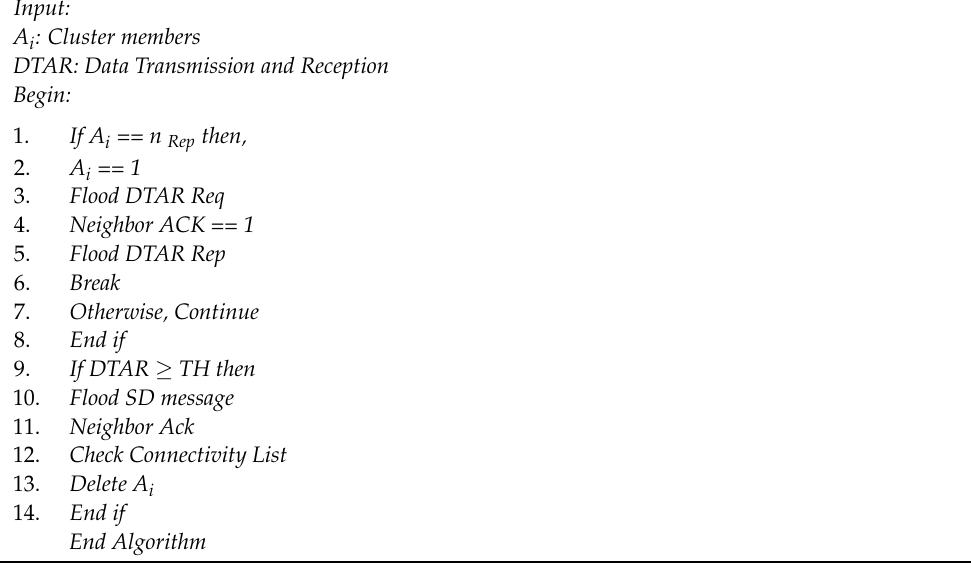
Algorithm 2. For the Detection and Identification of Spoofing